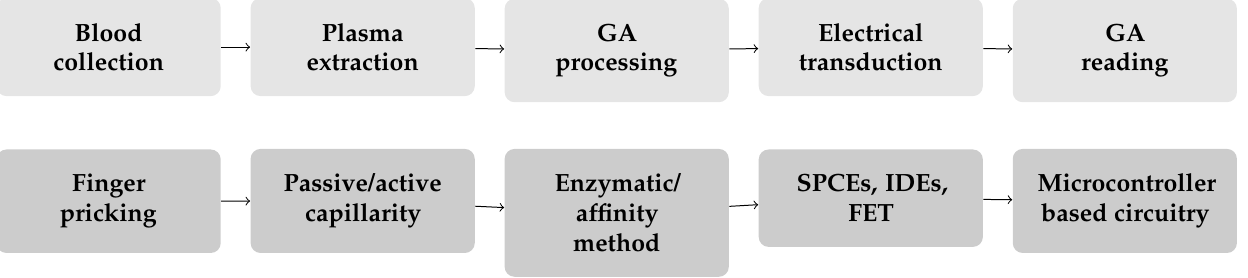
Figure 5. Schematic representation of the hypothesized steps involved in a POC testing device. The actions to be performed are on top, whereas, at the bottom, the solutions that could be adopted to fulfill the respective